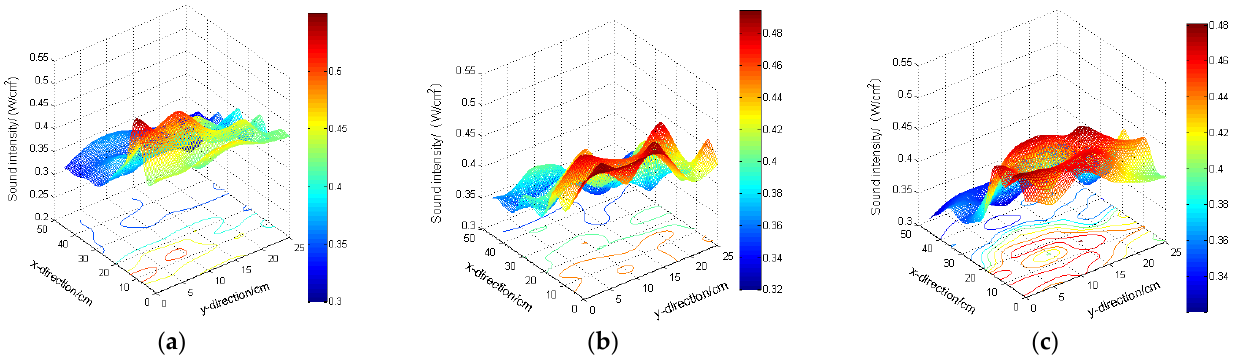
Figure 13. Ultrasonic sound intensity distribution. ( a ) Bottom surface of ultrasonic vibration plate; ( b ) 5 cm from the bottom surface of ultrasonic vibration plate; ( c ) 10cm from the bottom surface of ultrasonic vibration plate.